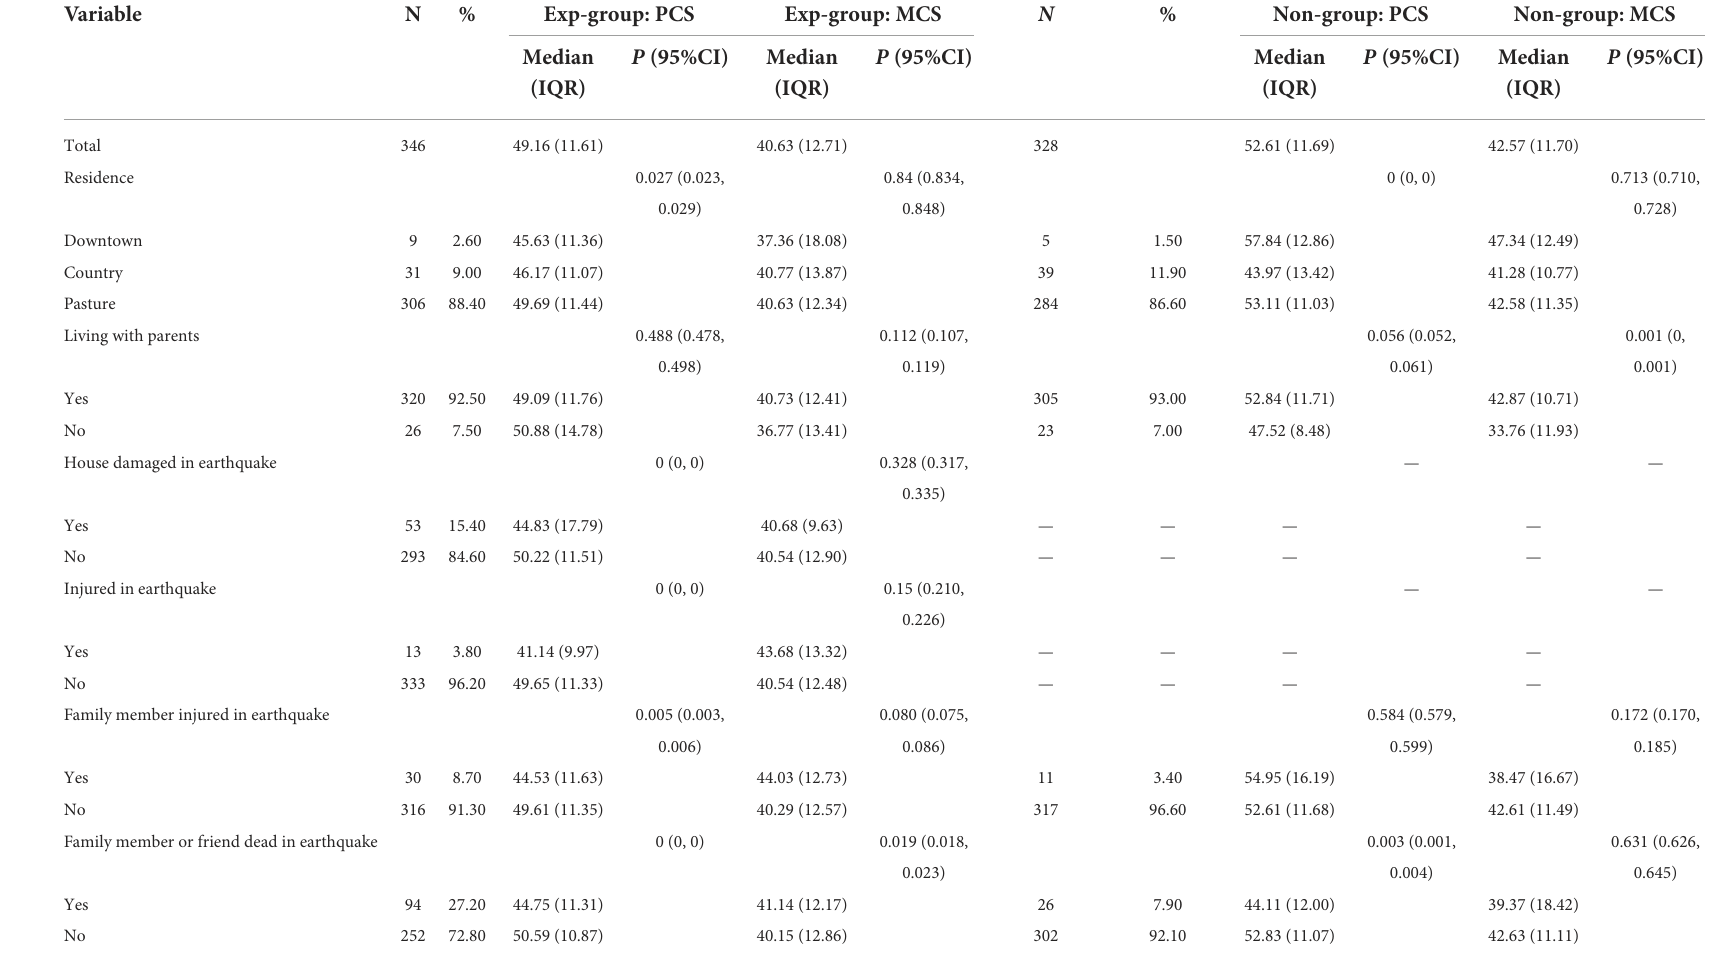
TABLE 1 Nonparametric rank-sum test of differences in PCS and MCS scores across the exp-group and non-group.